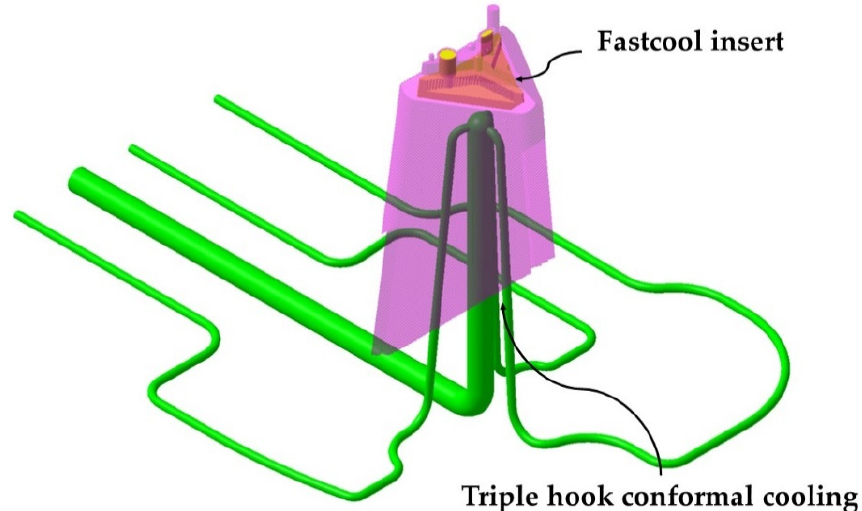
Figure 6. Fastcool insert.